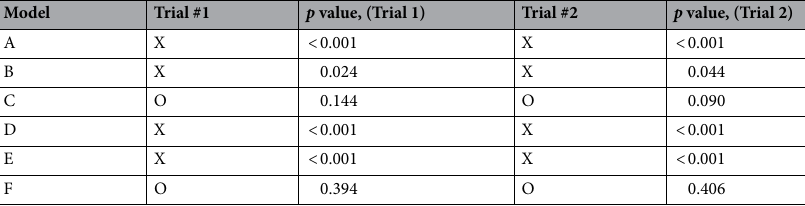
Table 5. ANOVA results for consistency in ΔT between ten NCIT units of the same model for each trial independently. “O” stands for no statistical difference between ten NCIT units, while “X” indicates statistical difference between ten NCIT